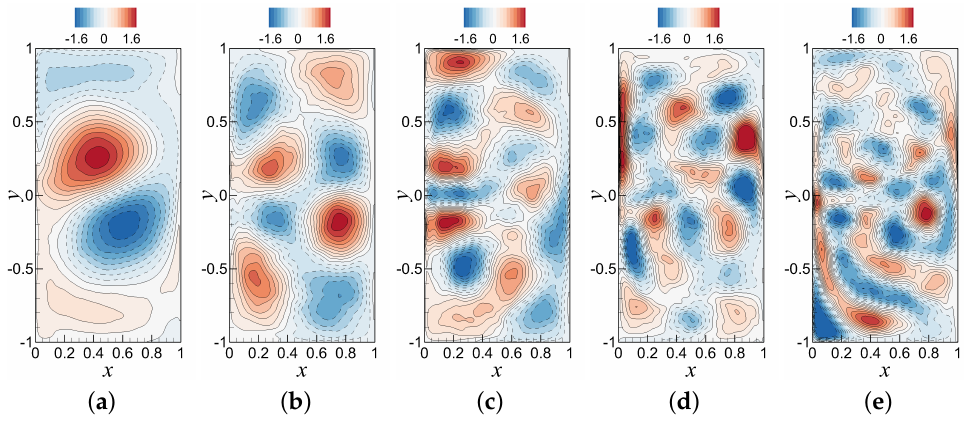
Figure 4. Contour plots of some illustrative examples of POD basis functions for Re = 100 generated by the method of snapshots: ( a ) ϕ 1 ( x , y ) ; ( b ) ϕ 10 ( x , y ) ; ( c ) ϕ 20 ( x , y ) ; ( d ) ϕ 30 ( x , y ) ; and ( e ) ϕ 40 ( x , y )